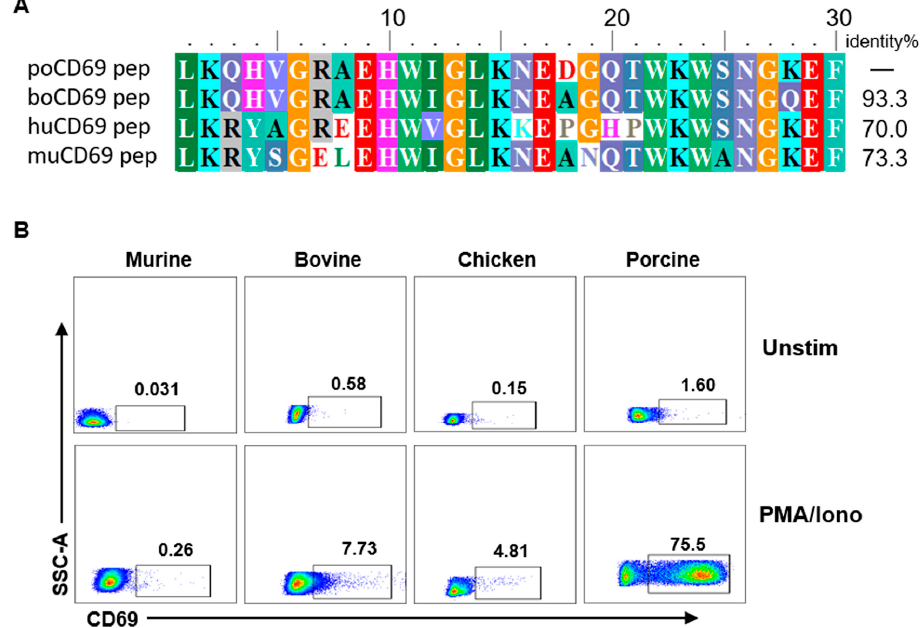
Figure 3. Anti-poCD69 mAb 5F12 shows weak or no cross-reactivity with bovine, mouse, and chicken CD69. ( A ) Homologous comparison of CD69 polypeptide (aa 133–161) in pig samples and human, mouse, and bovine samples. The percentage of homology was indicated. ( B ) The cross-reactivities of Dylight ® 755-conjugated anti-poCD69 mAb 5F12 with PBMCs from mice, cows, and chickens were examined by flow cytometry after the in vitro stimulation of PBMCs with or without PMA (50 ng/mL) and ionomycin (500 ng/mL) for 6 h (Unstim vs. PMA/Iono). The CD69 + lymphocytes were gated on lymphocytes within PBMCs. The data shown are representative of three independent experiments. 3.4. Detection of CD69 Expression on Different Leukocyte Subsets by Flow Cytometry CD69, as an early activation marker, is expressed on activated B cells, T cells, NK cells, macrophages, monocytes, and granulocytes [4,33]. In order to test and validate if mAb 5F12 can be used to detect CD69 expression on different leukocyte subsets by flow cytometry, mAb 5F12 was purified and conjugated with fluorochrome DyLight ® 755 and then used to directly stain pig PBMCs after stimulation with PMA/ionomycin, along with a group of antibodies to define each subset, as previously reported [27,32]. As shown in Figure 4 and Figure S1, CD69 is dominantly expressed on CD21 + B cells (45.8 ± 2.65%) and T cell subsets, including CD4 + (55.83 ± 2.25%), CD8 + (42.6 ± 2.86%) and CD4 + CD8 + T cells (53.1 ± 3.29%) but is only expressed slightly on NK cells (CD3 − CD8 α + ), mono- cytes/macrophages (MHCII + CD163 + ), and neutrophils (MHCII − 27 CD163 − CD172 + )